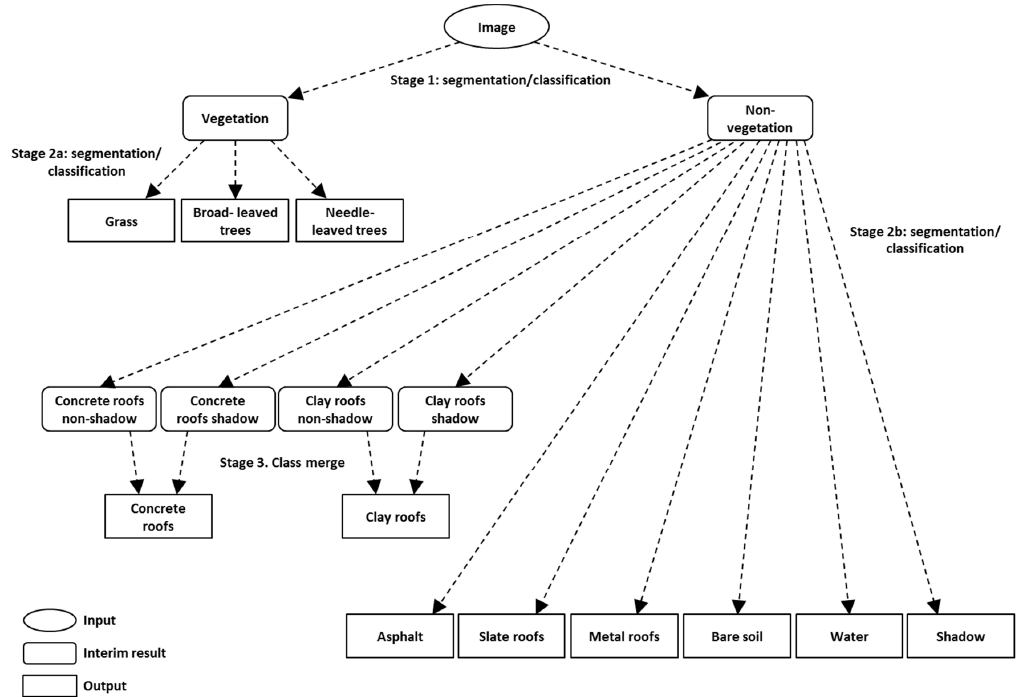
Figure 4. Multi-stage object-based classification procedure.